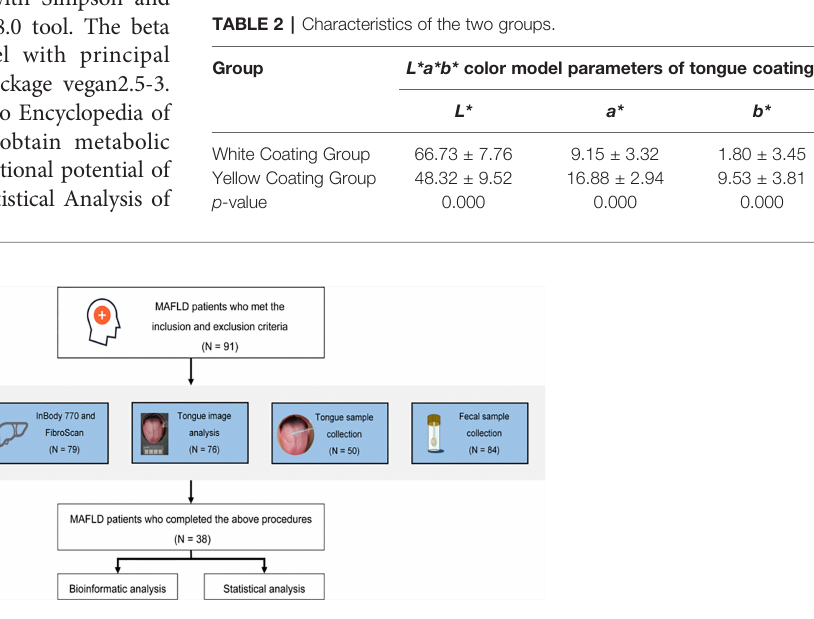
FIGURE 1 | Program fl owchart.